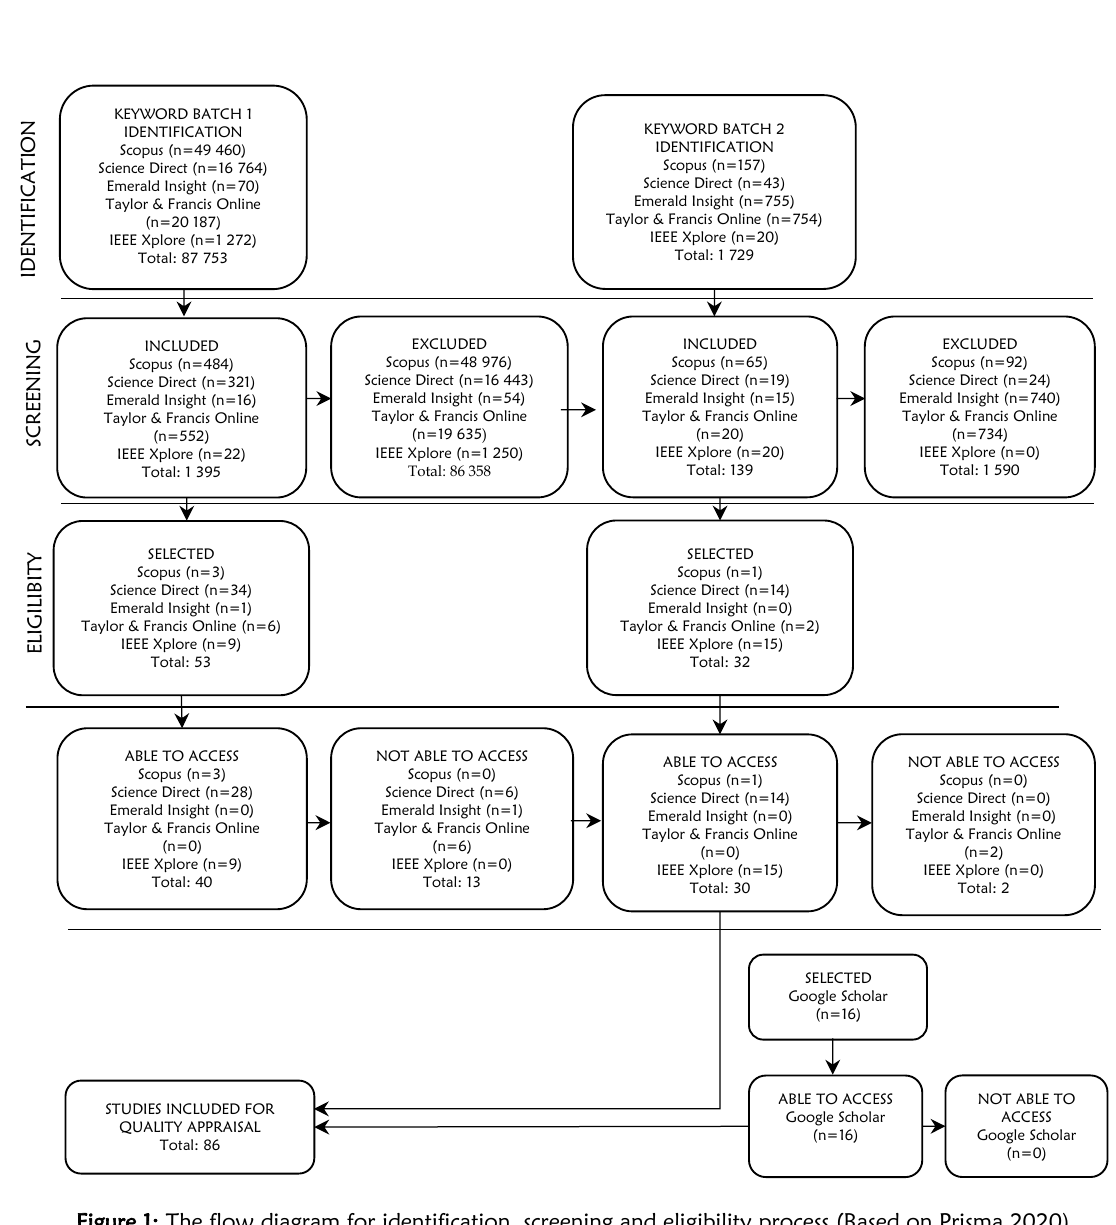
Figure 1: The flow diagram for identification, screening and eligibility process (Based on Prisma